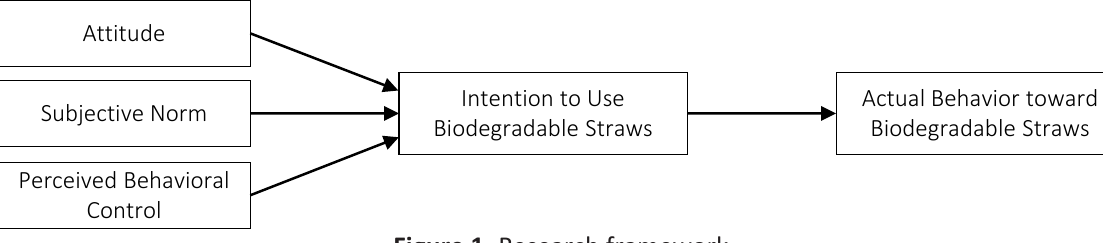
Figure 1. Research